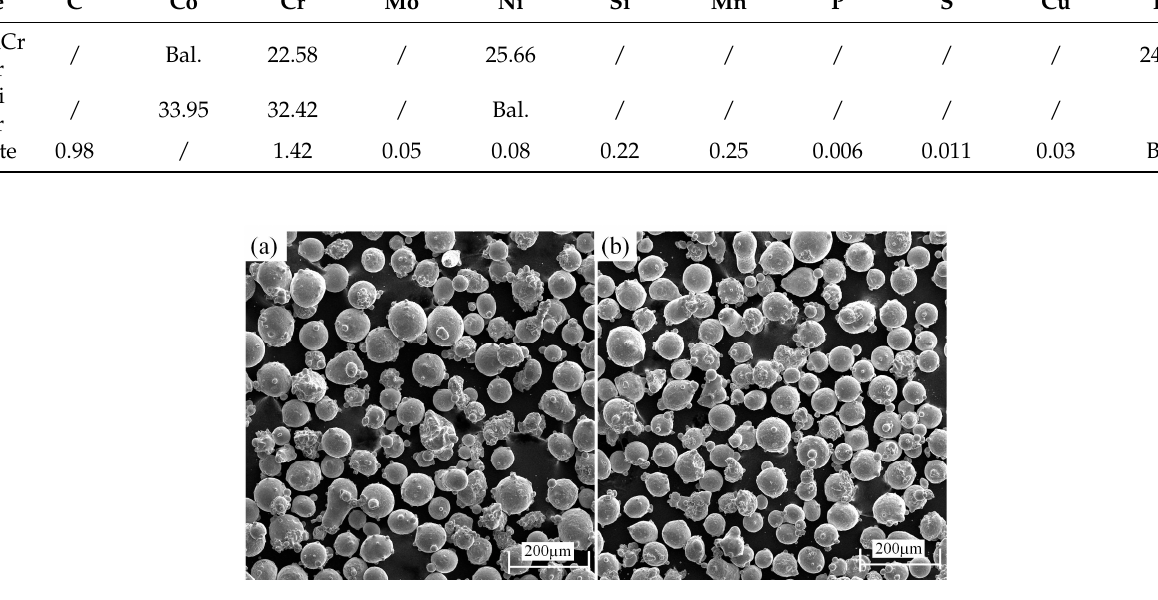
Figure 1. SEM images of MEA powder morphology, ( a ) FeCoNiCr, ( b ) CoCrNi.